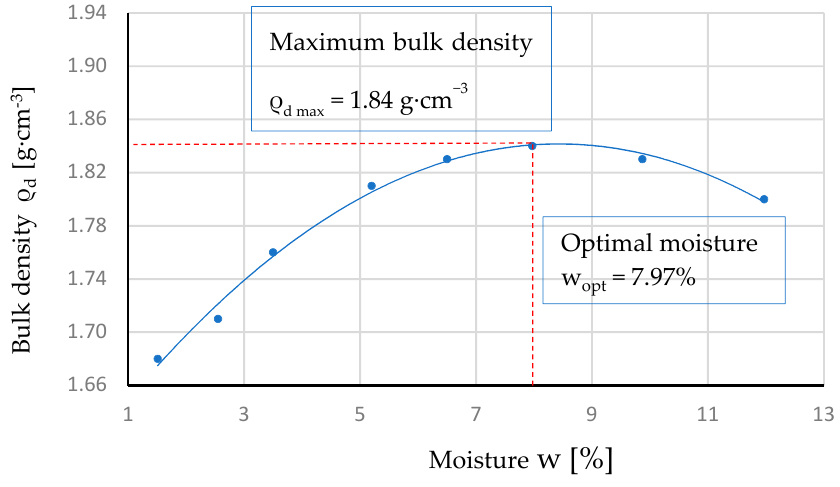
Table 3. Physical properties of the aggregates.